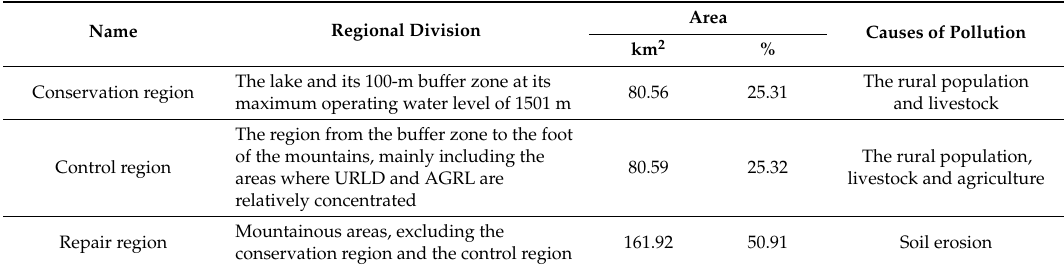
Table 6. NPS pollution control regional